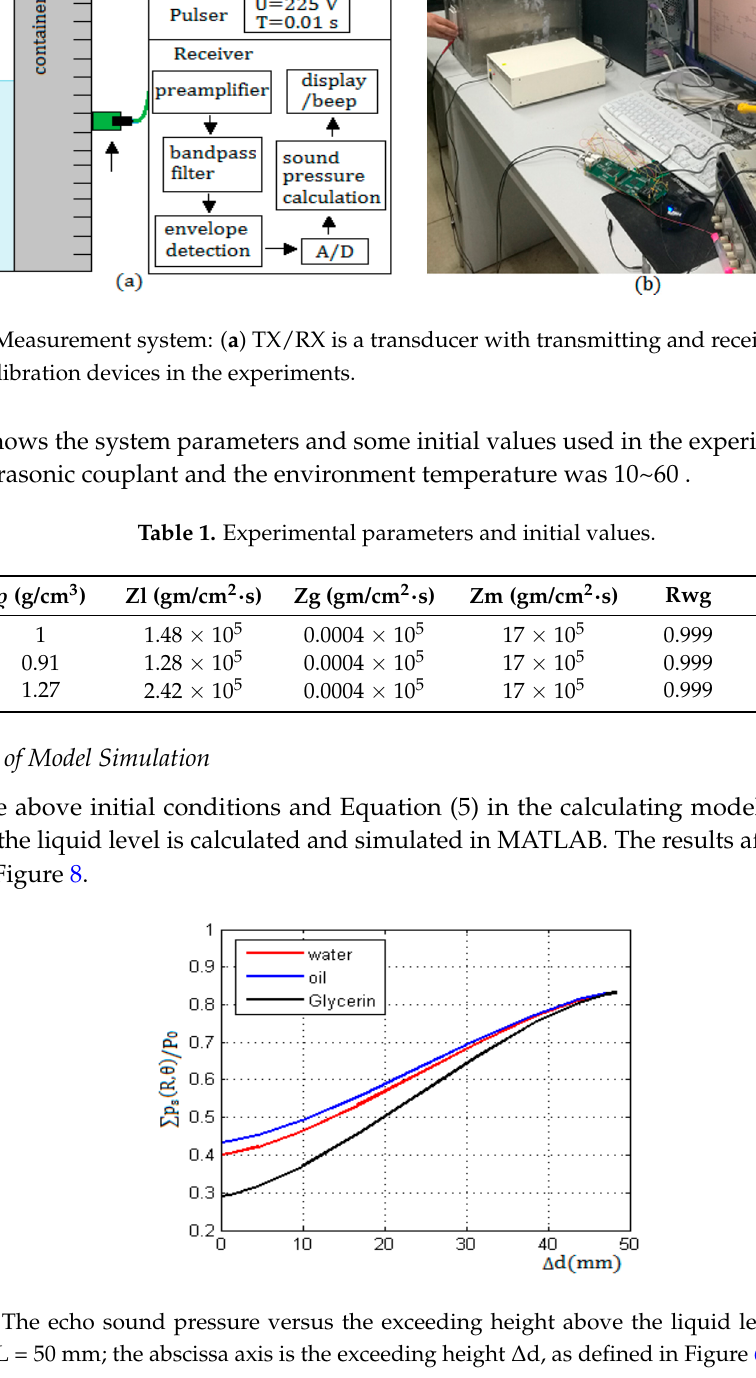
thickness L = 50 mm; the abscissa axis is the exceeding height ∆ d, as defined in Figure